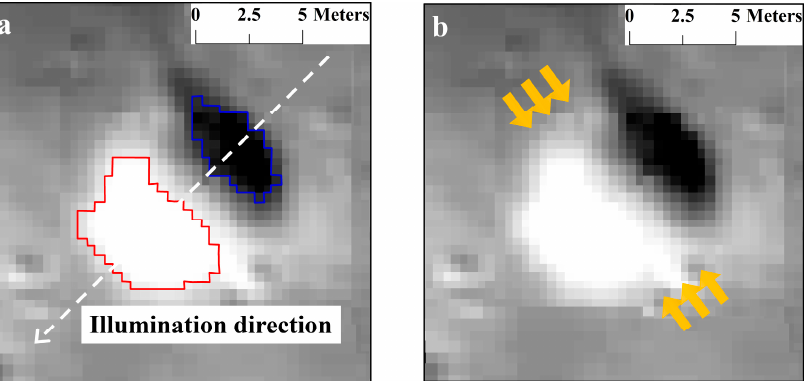
Figure 2. Visual identification criteria of impact crater features. ( a ) Crescent-like bright and dark regions. ( b ) Circular shape, yellow arrows mark the impact crater boundaries.